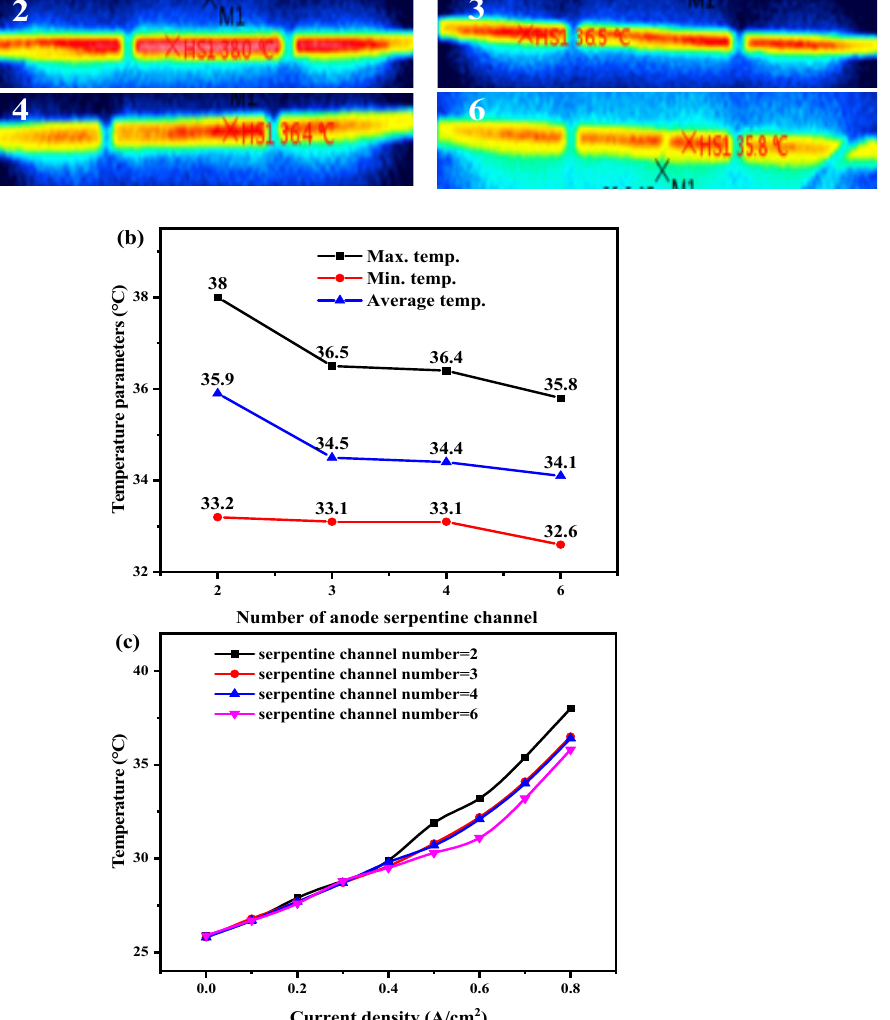
Figure 4. ( a ) Temperature distribution at 0.8 A/cm 2 , ( b ) maximum, minimum, and average temperatures, and ( c ) variation of hot spot temperature with current densities of the open-cathode PEMFC with different anode serpentine channel numbers.